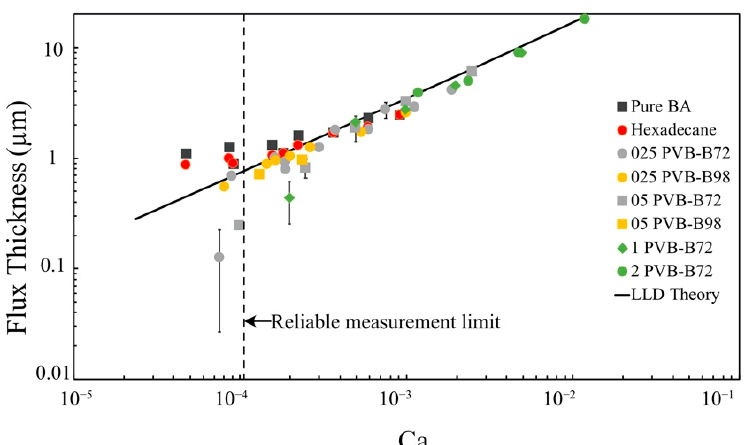
Figure 6. The film thickness ℎ (cid:2998)(cid:3033) on a brass wire (R = 0.255 mm) vs. capillary number. Pure viscous fluids (pure BA, hexadecane) and viscoelastic fluids (PVB-BA solutions) were examined. The solid line is Equation (10), the LLD theory for fibers ( ℎ (cid:2998)(cid:3033) ). The data on the right side of the dashed vertical line have the greatest accuracy with the given methodology.